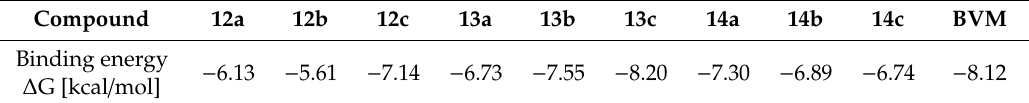
Table 3. Binding affinities of 3-carboxyacylbetulinic acids ( 12a-c , 13a-c , 14a-c ). Compound